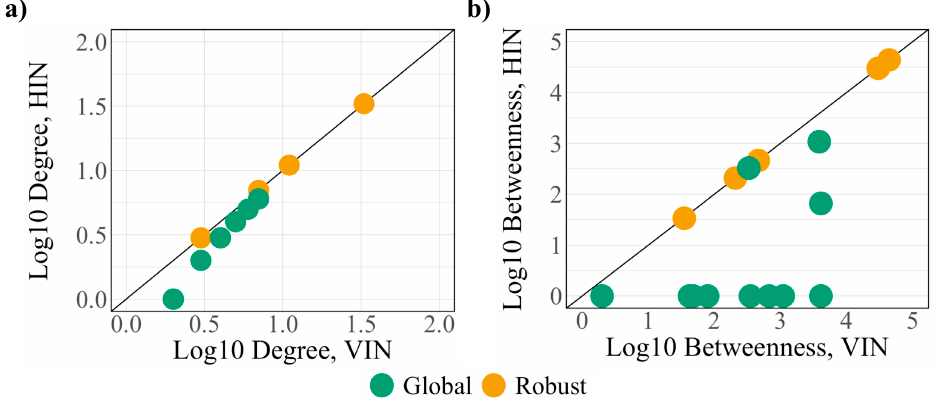
Figure 4. A comparison of the ( a ) degree and ( b ) betweenness of the robust (yellow) and global (green) protein sets.